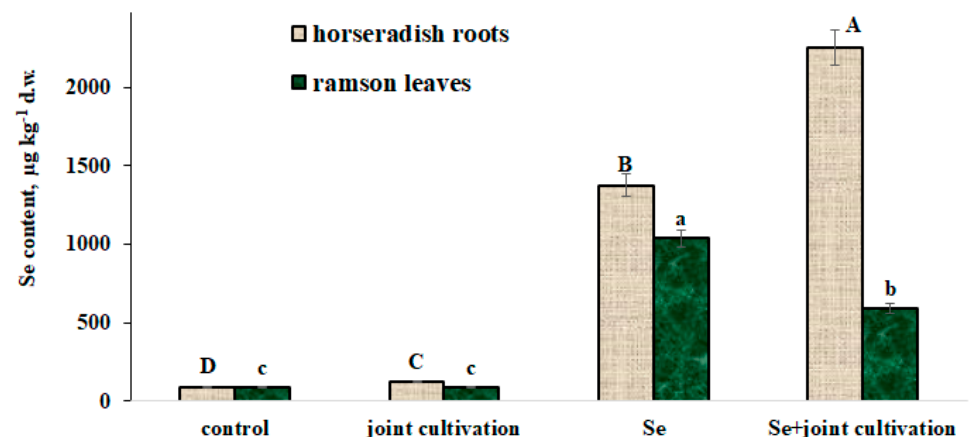
Figure 3. Effect of separate and joint cultivation of ramson and horseradish under Se supply on plant Se accumulation. Values with similar letters do not differ statistically according to Duncan test at p < 0.05